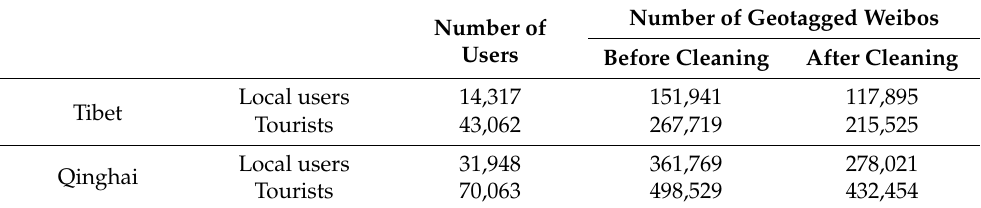
Table 1. Number of geotagged Weibos texts and users.